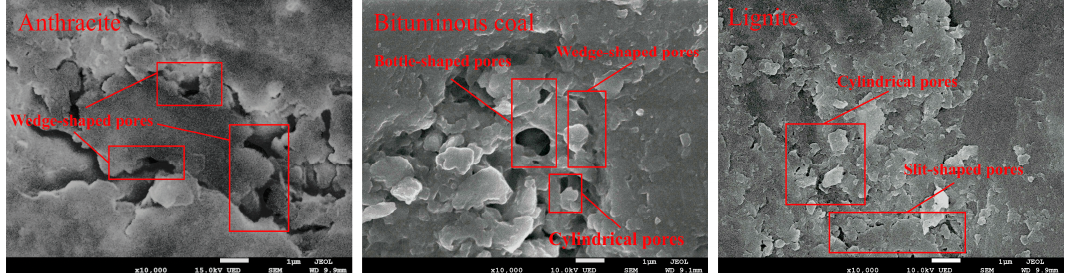
Figure 3. SEM images of the coal samples.